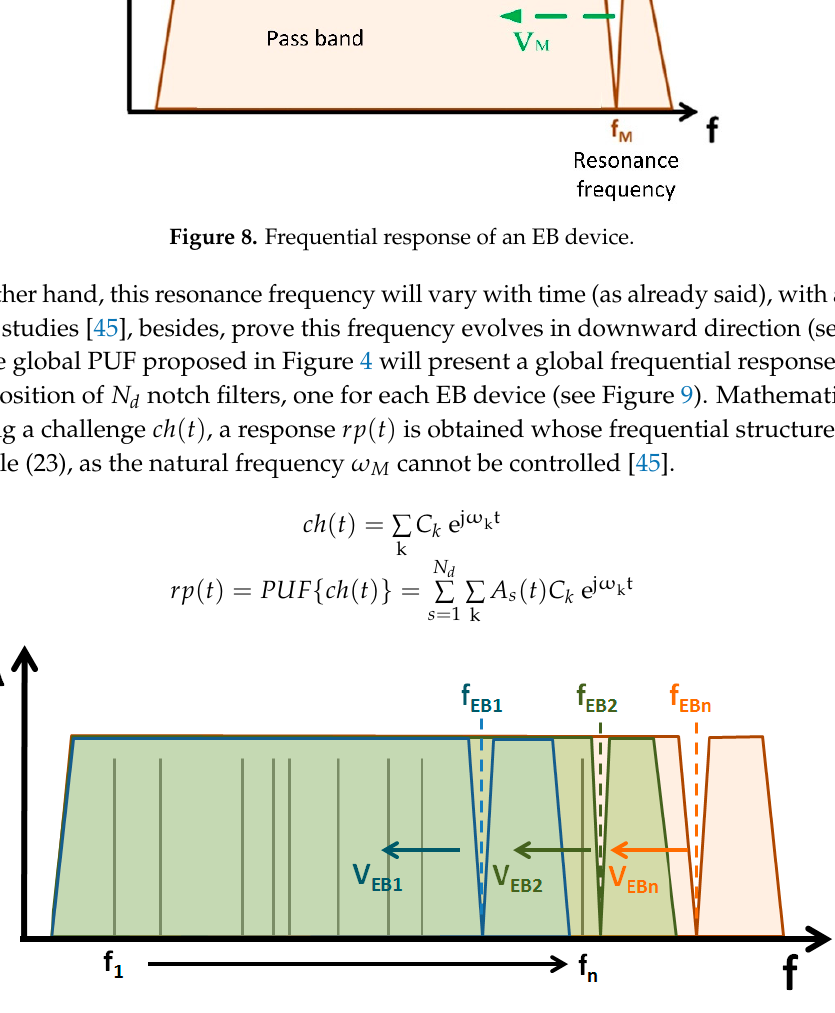
Figure 9. Operation of the complete PUF.